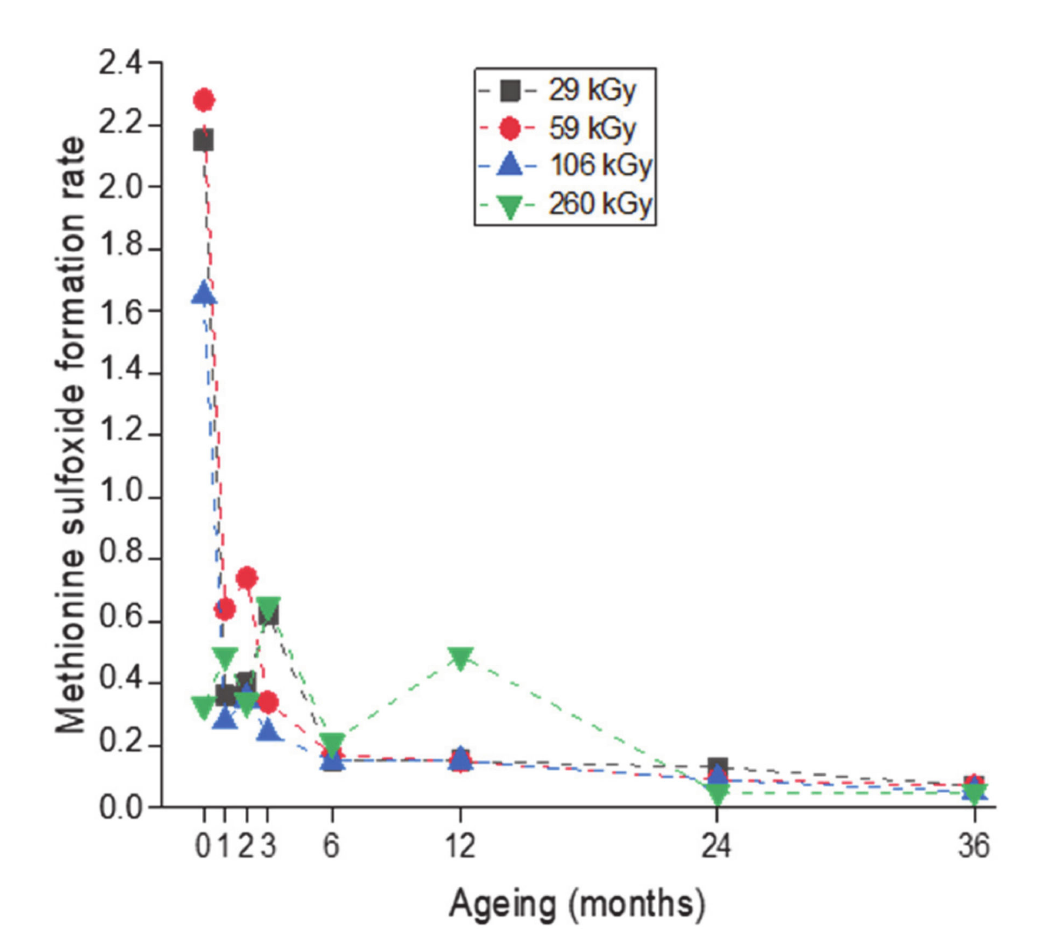
Figure 5. Plots of aging before filling versus methionine sulfoxide formation rate at di ff erent